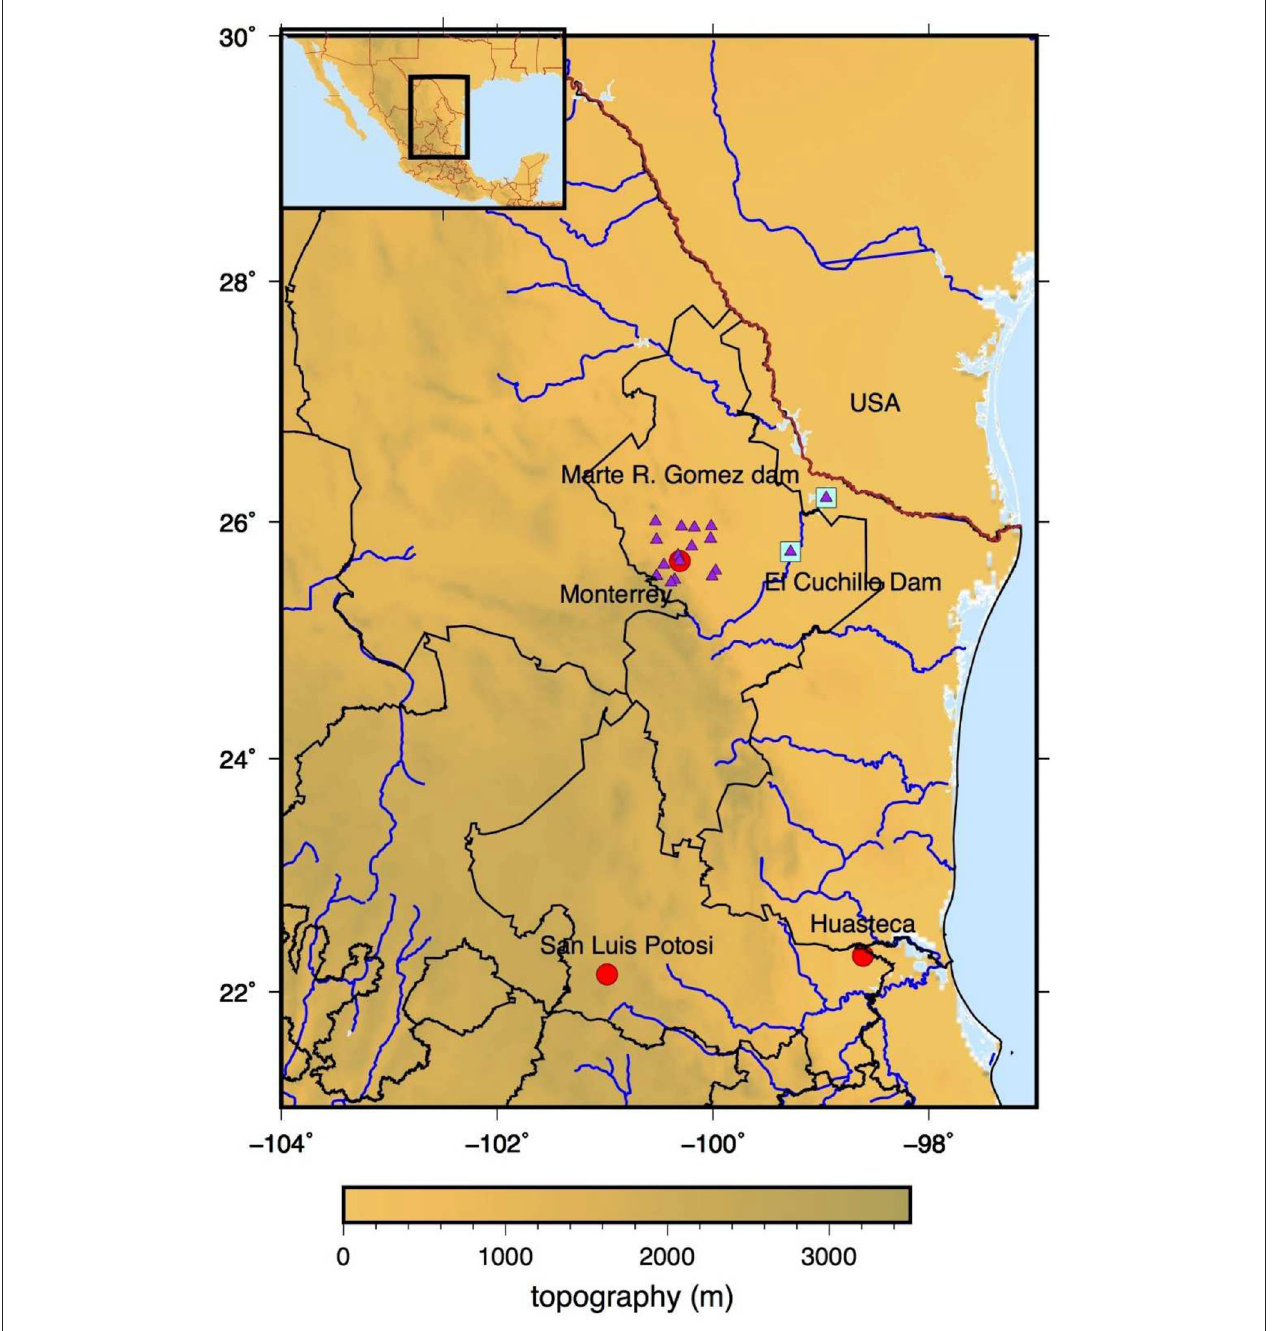
FIGURE 1 | Northeastern Mexico, showing the Monterrey Metropolitan Area (red circle). El Cuchillo Dam reservoir, Marte R. Gomez dam reservoir, and the San Luis Potosi Huasteca area constitute three reference locations for the present study. Shading indicates topography and the purple triangles correspond to the location of the weather stations used in the